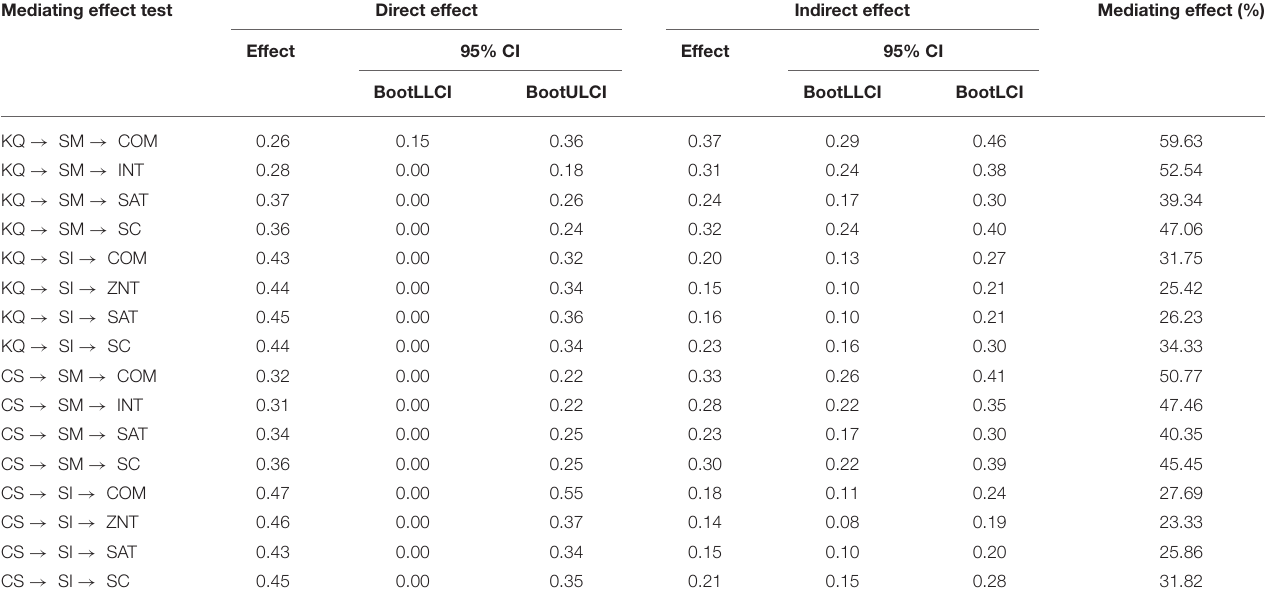
TABLE 5 | Mediating effect.